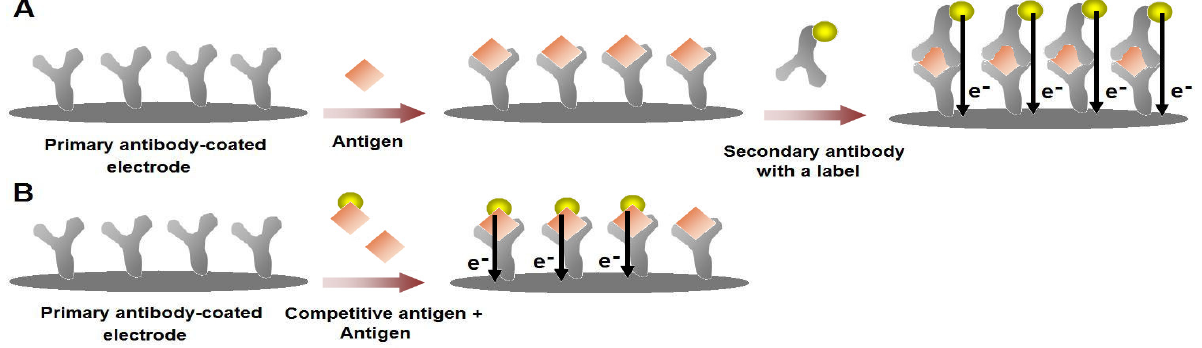
Figure 3. Schematic illustration for the general immunosensor formats. (A) Sandwich-type immunoassay with a labeled-secondary antibody. After the binding of the target antigen to the primary antibody-modified surface, the secondary antibody with a label is introduced to the form the sandwich- type complex. Various molecules such an enzyme or a nanoparticle can act as the source of electrochemical responses. (B) In a competitive-type immunosensor, the target molecule competes with its labeled form to attach on the primary antibodies on the surface. The electrochemical responses obtained from the labeled antigens are inversely proportional to the concentration of the target antigen. High sensitivity levels can be reached using competitive immunosensing